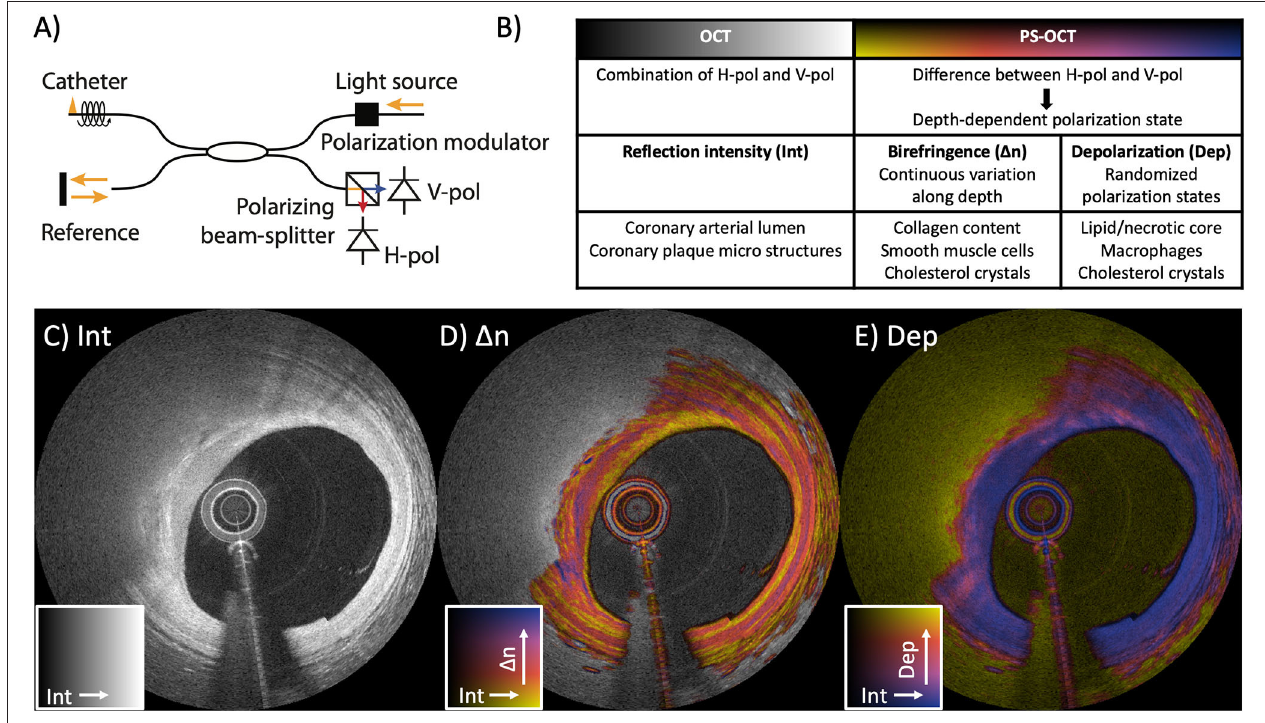
FIGURE 1 | Working principle of intravascular polarimetry (IVP) with polarization-sensitive optical coherence tomography (PS-OCT). IVP is compatible with current intravascular imaging catheters and enables measurements of tissue polarization properties, together with the conventional reflection intensity. (A) The only addition to conventional OCT for enabling PS measurements is a polarization modulator that alternates the polarization state of the light incident on the tissue between depth scans. (B) Analyzing the spatial variation of the detected states allows reconstruction of birefringence ( 1 n) and depolarization (Dep), in addition to the conventional reflection intensity image (Int). (C–E) IVP of a lipid-rich plaque imaged in the left anterior descending coronary artery of a 75-year-old male patient. (C) Intensity (Int) of the reflection signal visualizing subsurface plaque morphology in a conventional logarithmic gray scale. (D) Birefringence ( 1 n) in color hue, overlaid on the reflection signal in brightness, revealing a variety of birefringence features. Birefringence is displayed only in areas of low depolarization. (E) Depolarization (Dep) in color hue, overlaid on the reflection signal, showing areas of pronounced depolarization. Reproduced from Villiger et al. (